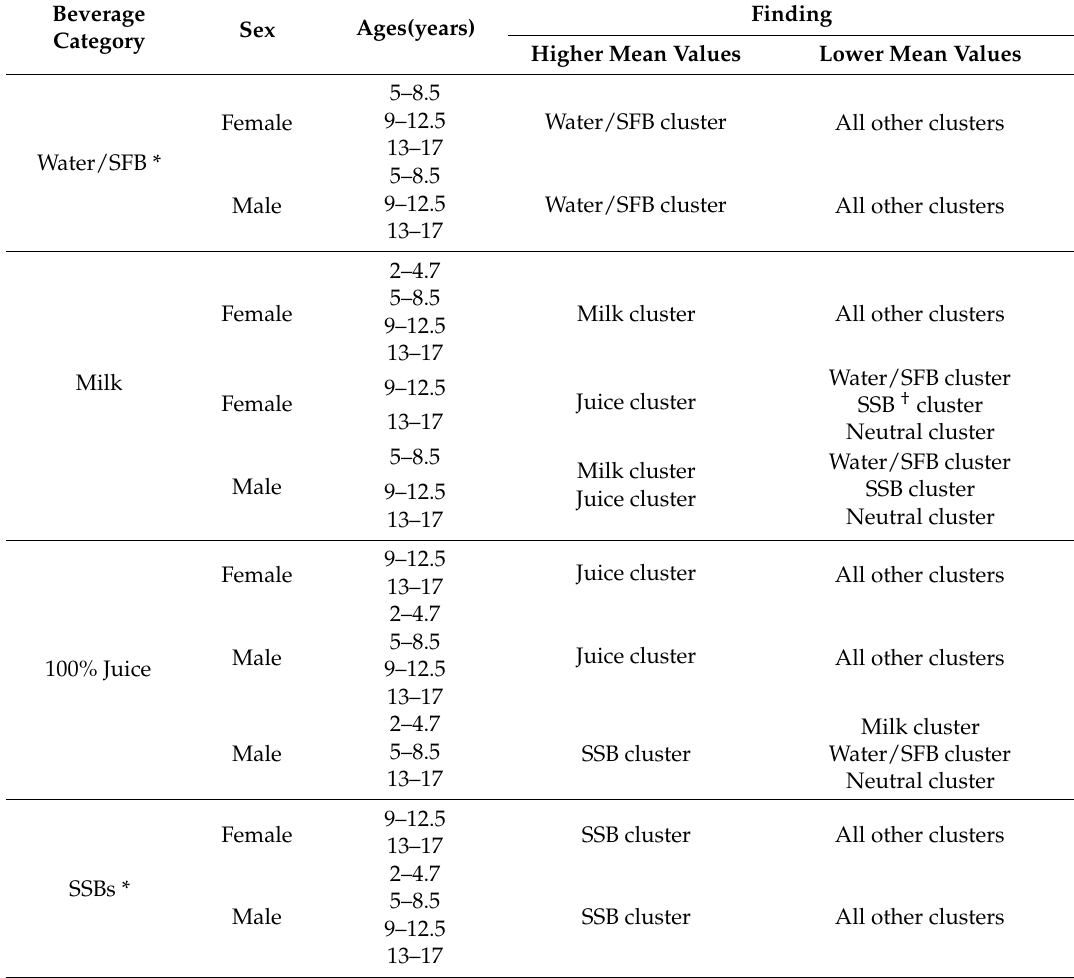
Table 1. Summary of sex- and age-specific findings pertaining to mean beverage intake differences